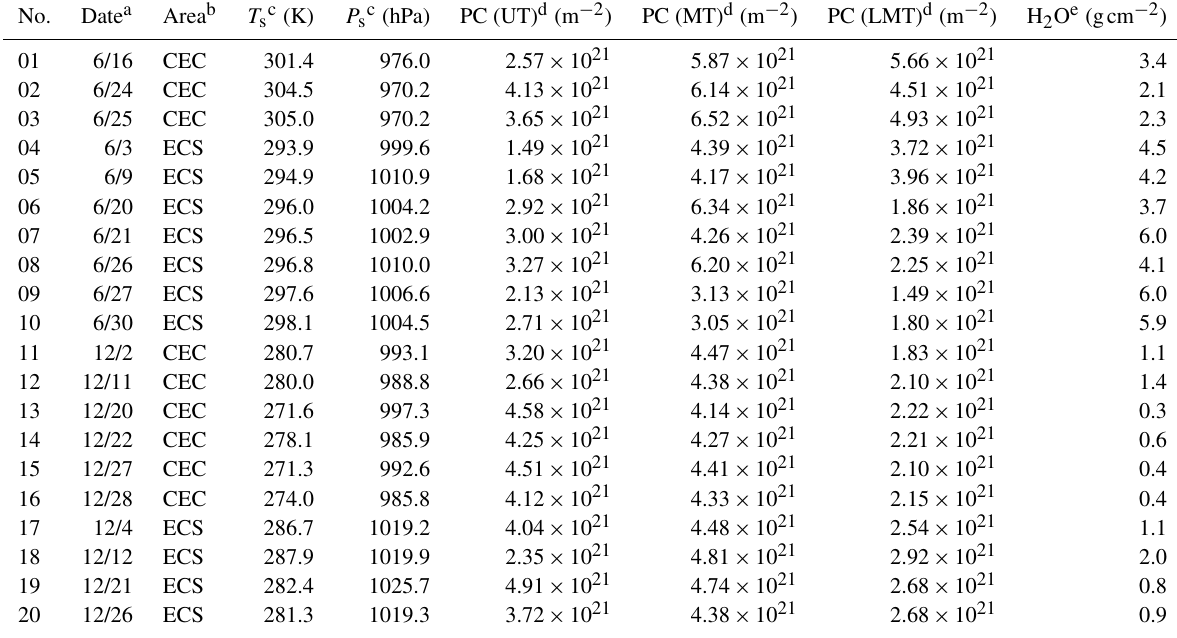
Table 3. Summary of 20 atmospheric scenarios used in the simulation.